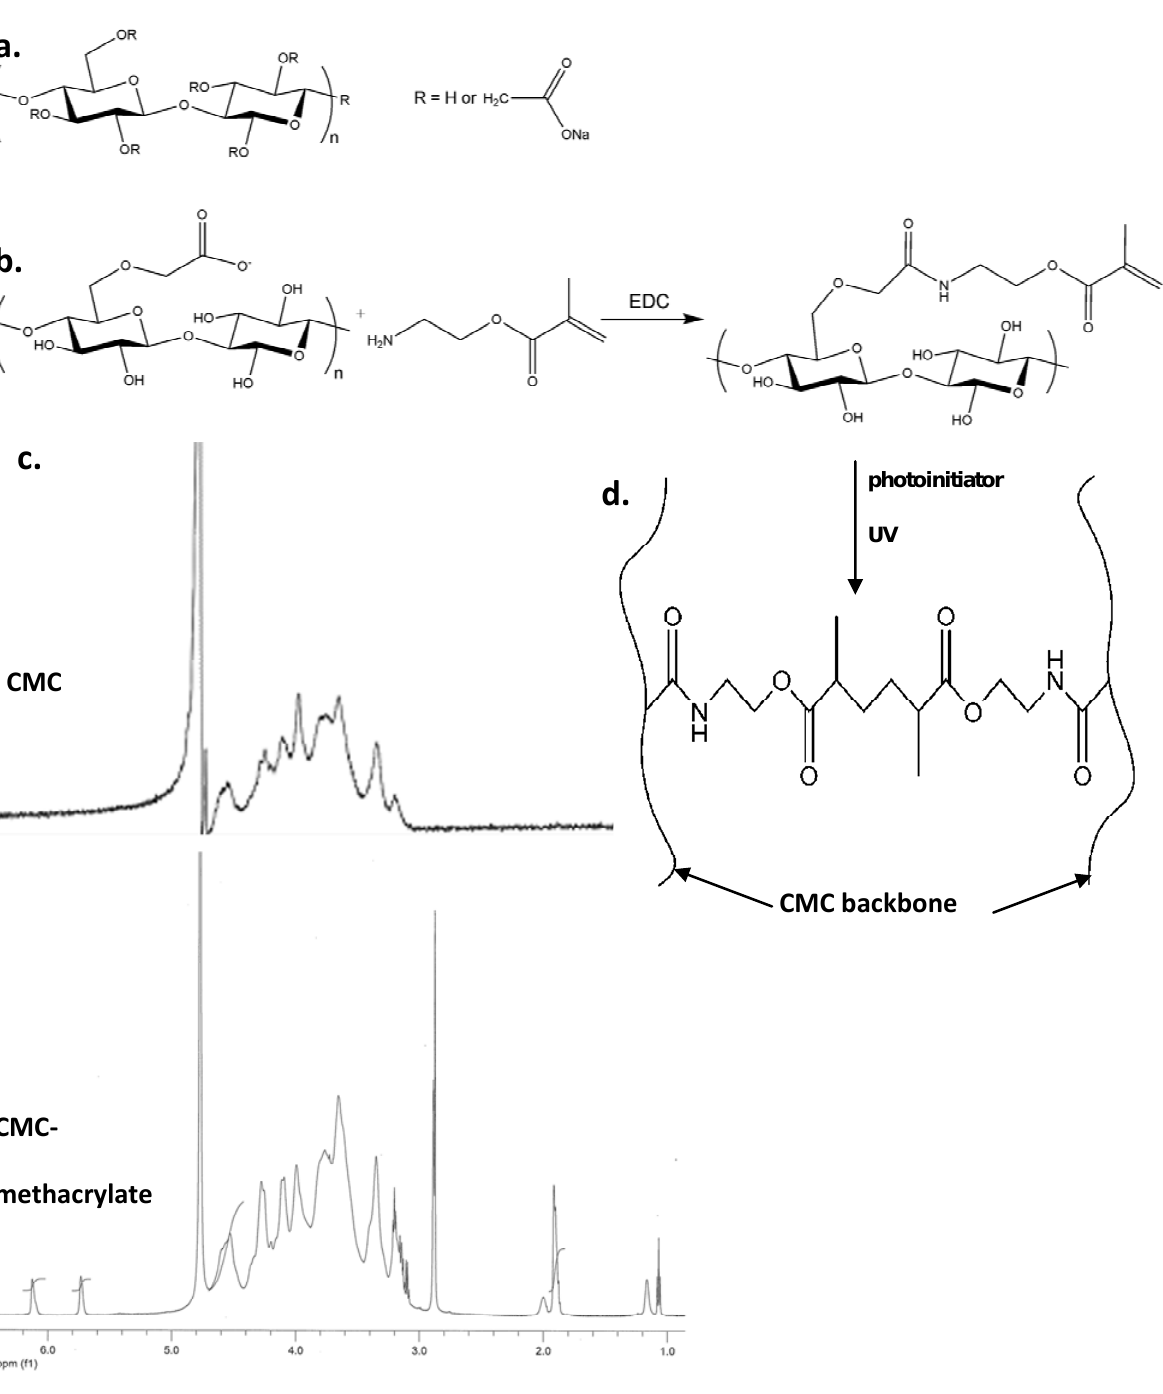
Figure 1. CMC (a) is a derivative of cellulose that has been modified with carboxymethyl groups to render the polymer soluble in aqueous solutions. In this work, the degrees of substitution (moles carboxymethyl groups per mol of cellulose disaccharide) were 0.7 and 0.9 for 90 and 700 kDa CMC, respectively. CMC-methacrylate was synthesized by an EDC-mediated reaction between CMC and aminoethyl methacrylate (b) . 1 H-NMR analysis (c) indicates ~15% substitution of methacrylate groups per CMC disaccharide repeat.